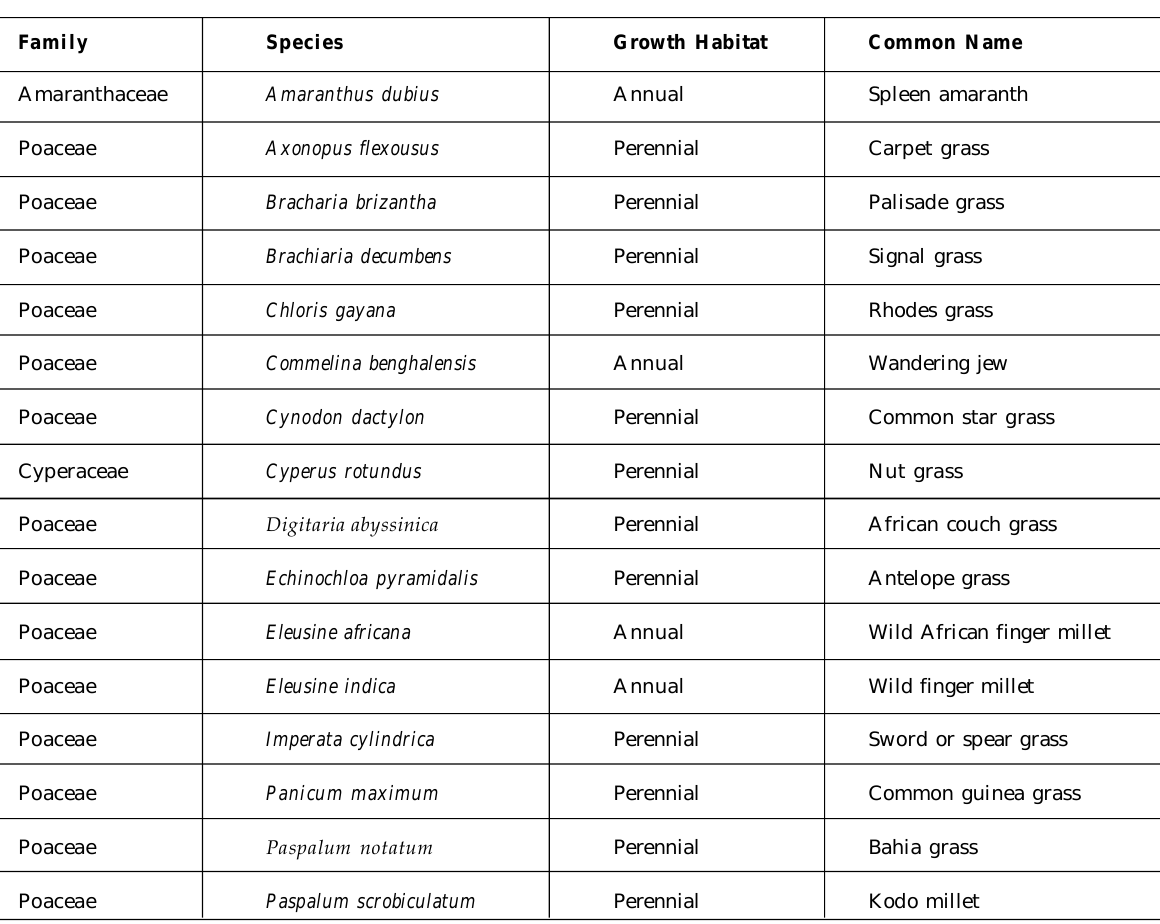
Table 1: Weed species used in the experiment Family Species Growth Habitat Common